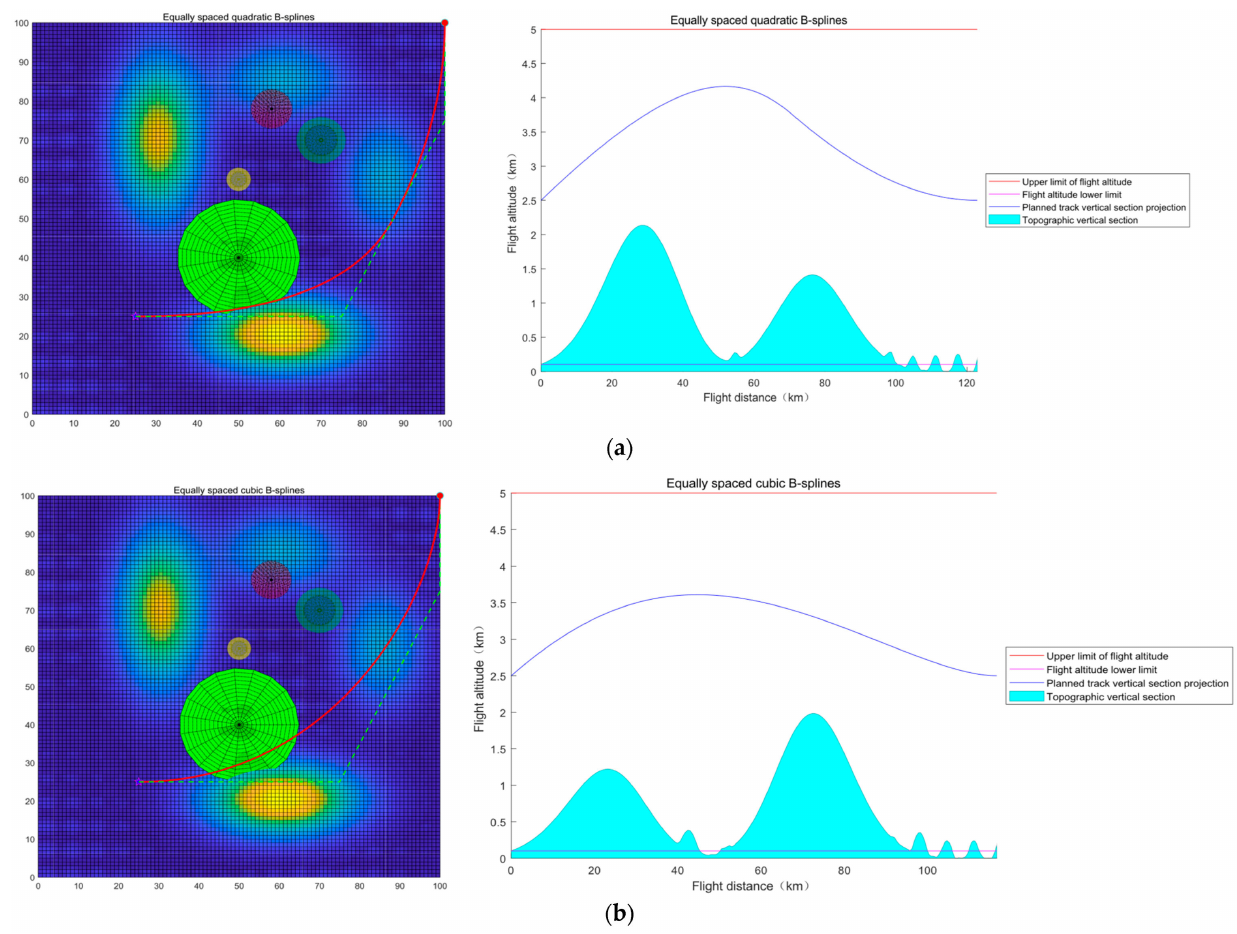
Figure 23. Top view and altitude curve after route smoothing. ( a ) Equally spaced quadratic B-spline smoothing, and ( b ) Equally spaced cubic B-spline smoothing. Table 4. Route smoothing experimental